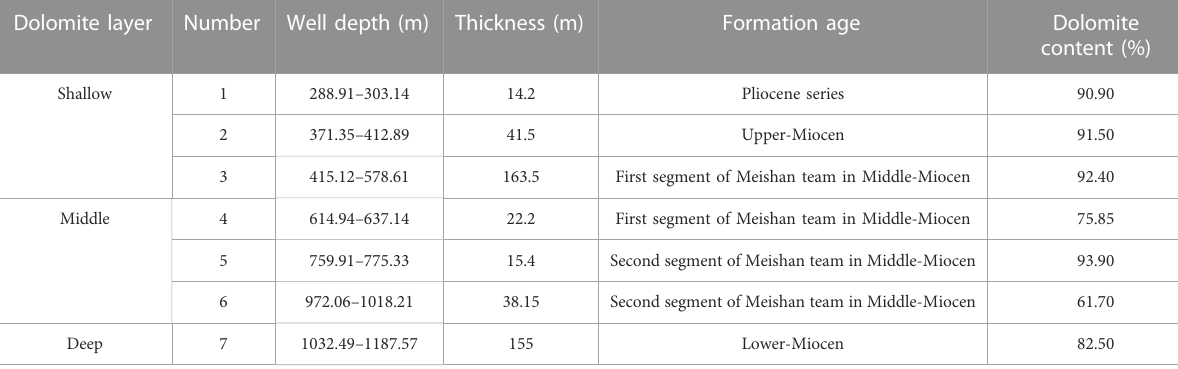
TABLE 1 Formation thickness and content of dolomite in Well Xike